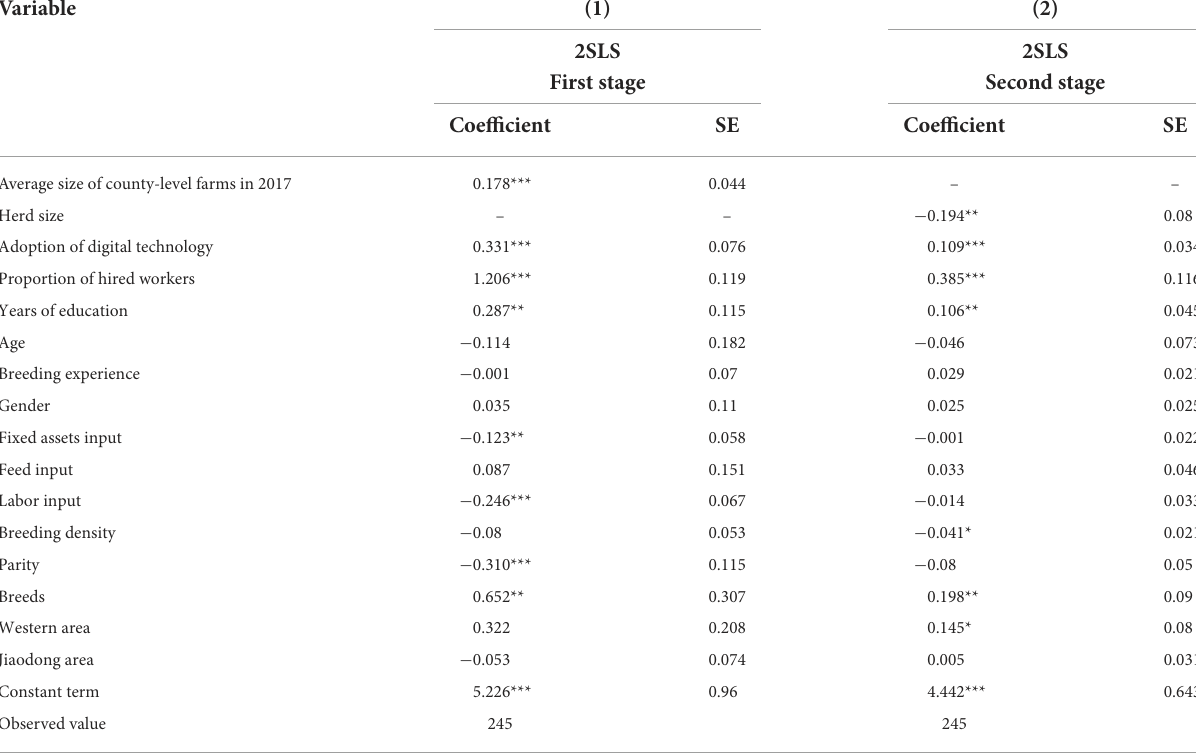
TABLE 5 Robustness test: the impact of herd size on the dairy cow yield by change the dependent variable.